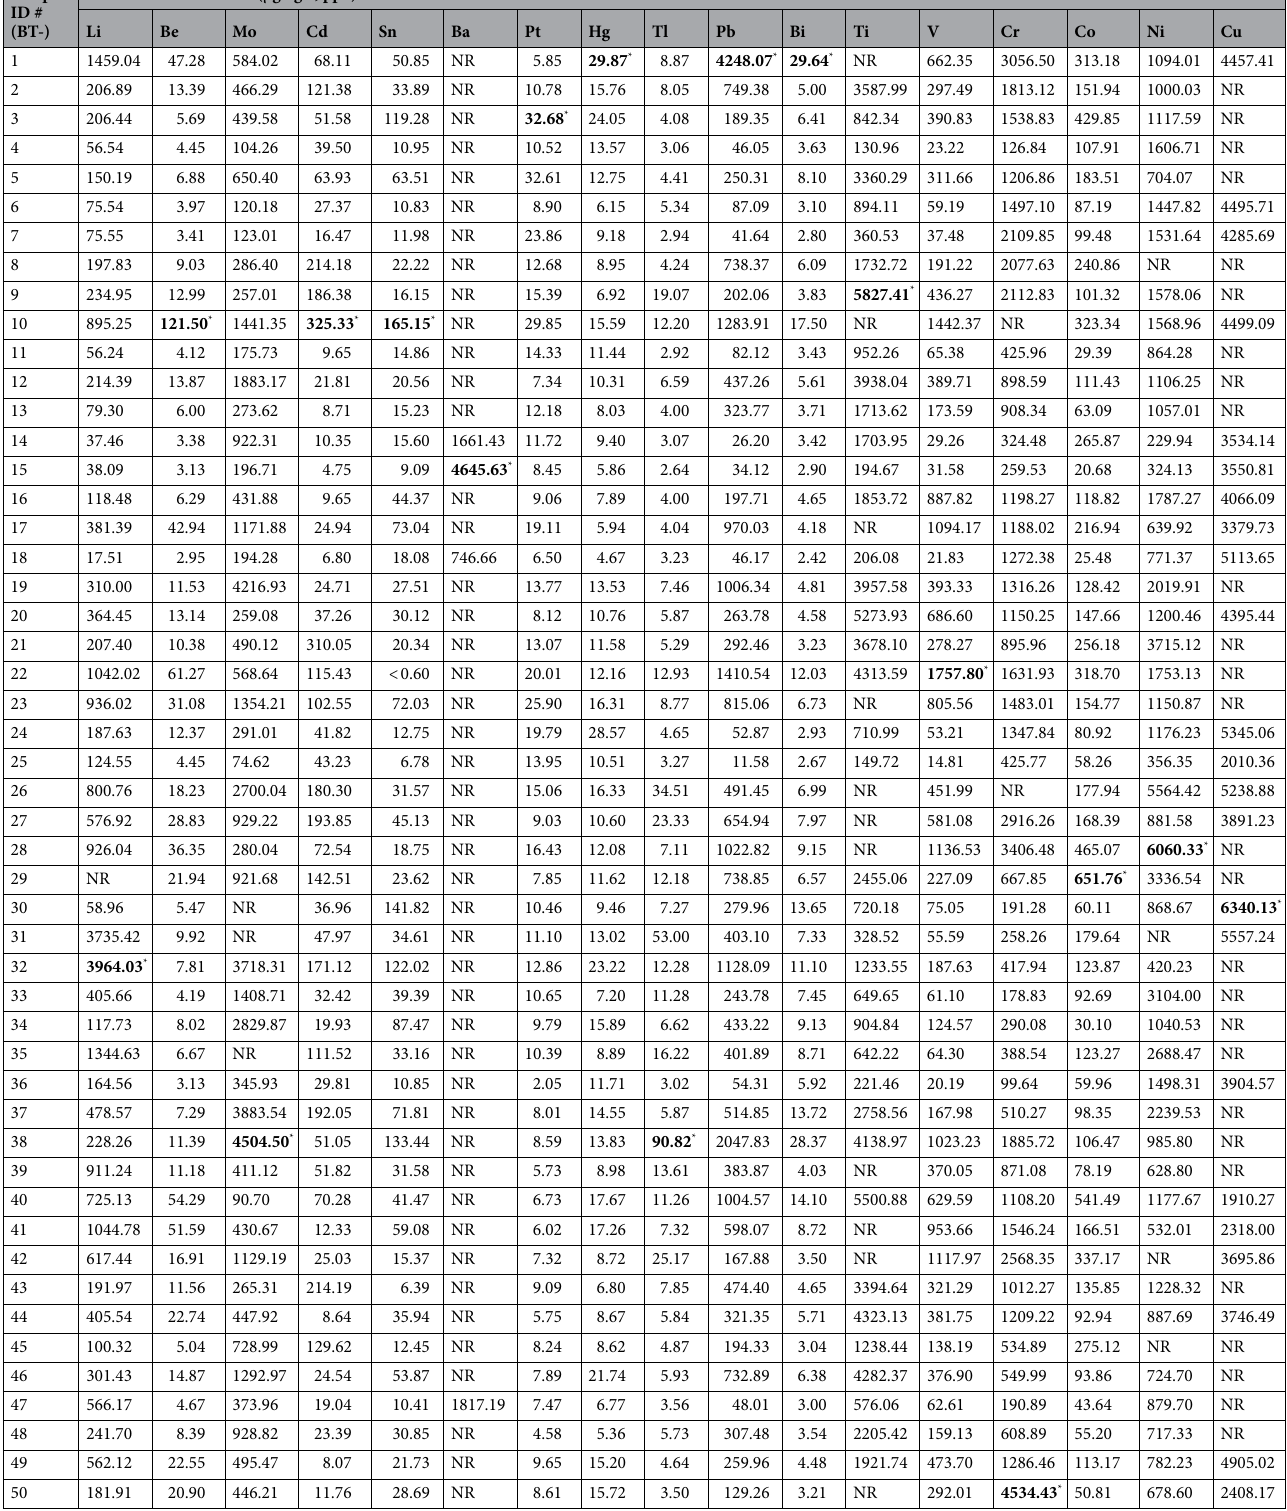
Table 5. Concentration (µg kg −1 )* of each element in sample (BT-1 to -50) following (HR) ICP-SFMS multi- elemental analysis. NR represents the element concentrations which exceeded the highest calibration standard and could not be accurately quantified. The concentrations of Al, Au, Fe, Mg, and Mn in all samples tested were outside the calibration range and could not be accurately determined; and thus, they are excluded from this table. *Highest quantified concentrations of the corresponding element(s) are highlighted in